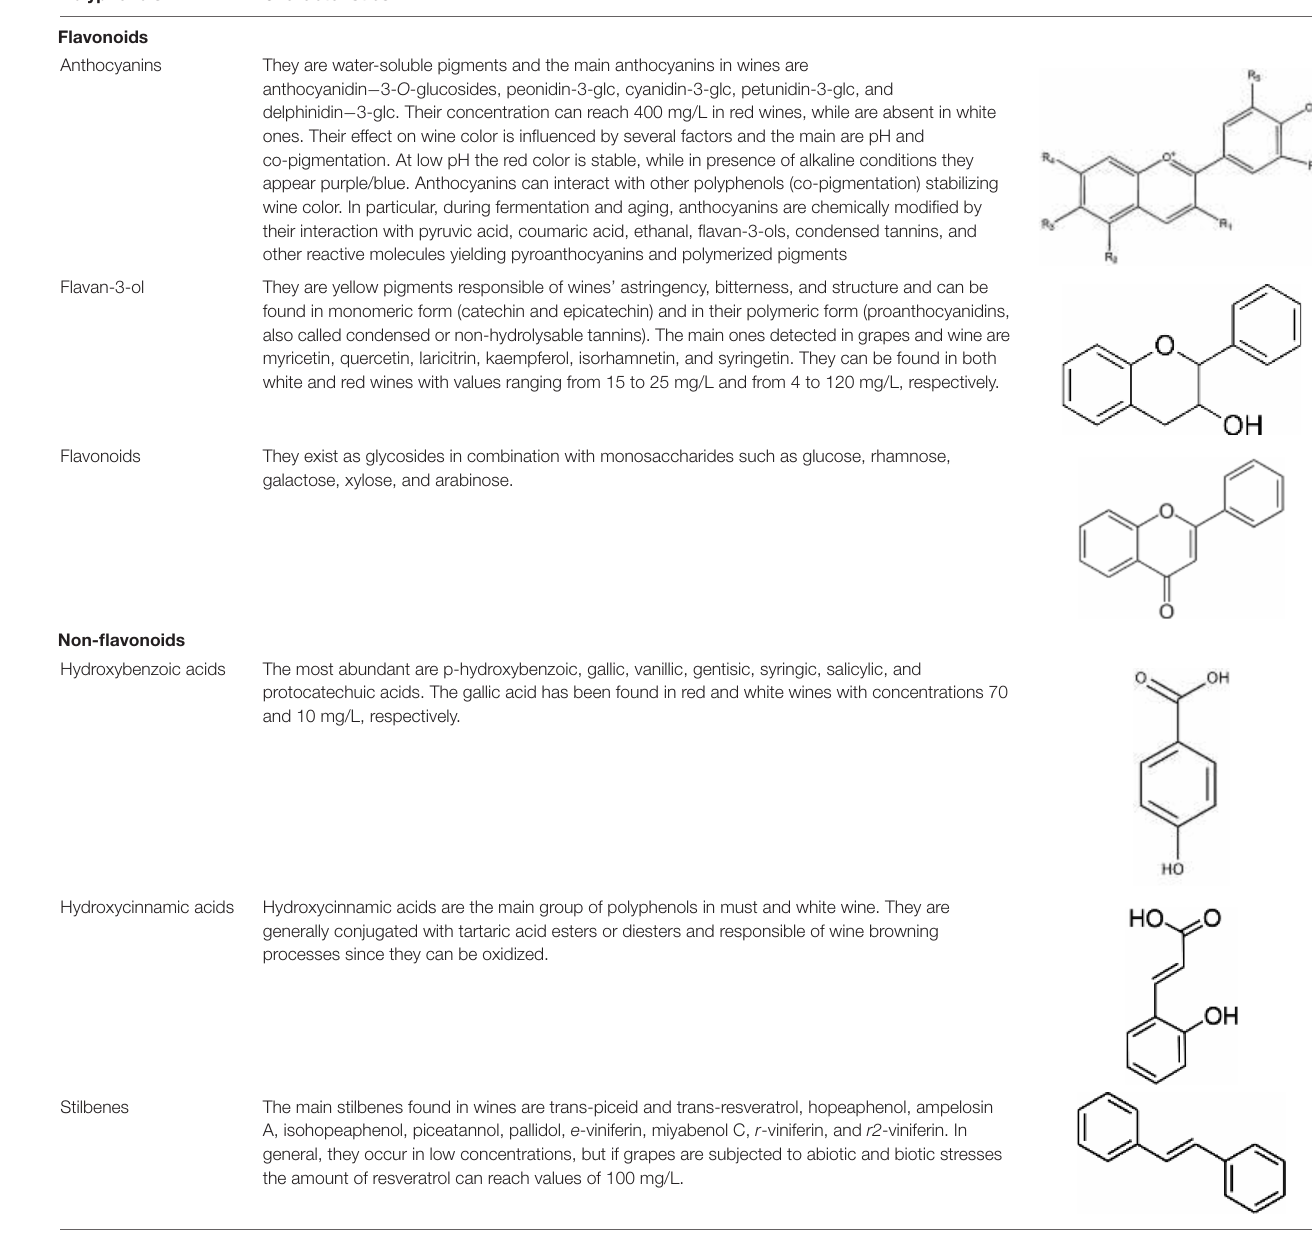
TABLE 2 | Characteristics of main polyphenols occurring in wine (modified by Visioli et al., 2020).